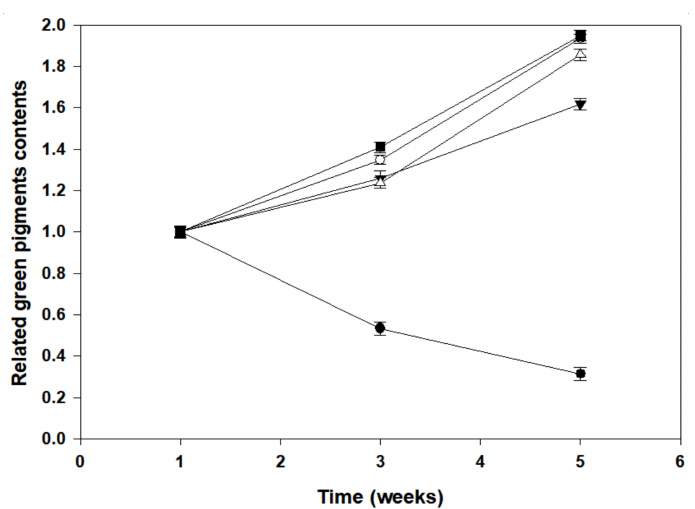
Figure 4. Variations in relative green pigment contents of newly developed leaves of Pachira macro- carpa plants fed 0% ( • ), 2% ( (cid:72) ), 4% ( (cid:52) ), and 6% ( (cid:4) ) glucose in complete darkness and in a lighted condition ( ). Each data point represents the mean ± SD of five independent (cid:35)